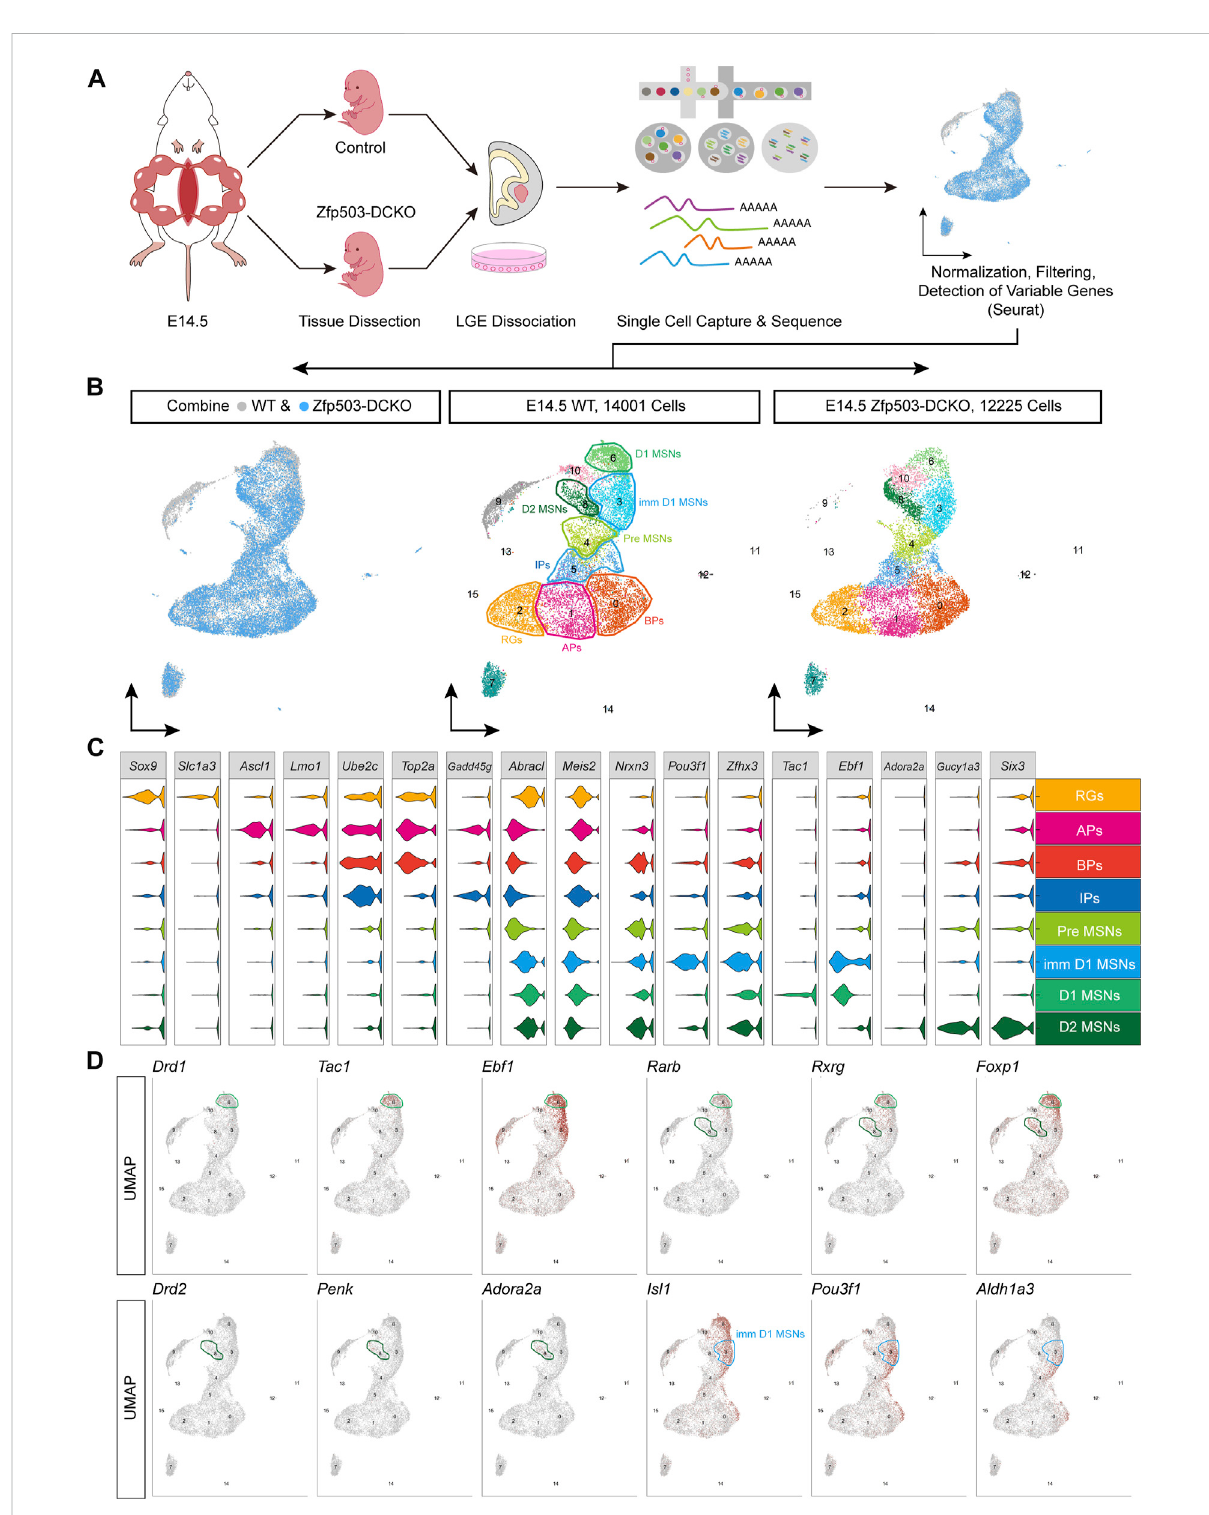
ThematurationofD1MSNsoccursearlierthanthatofD2MSNs. (A) Work fl owofscRNA-seqofLEGsamplesatE14.5.LGEtissuesweredissected from embryos and dissociated into single-cell suspensions. Single cells were captured into droplets with the 10x platform. After sequencing, cells were classi fi ed by their transcriptomes. (B) UMAP showing 16 clusters (C0 – C15); the major cell types are annotated in both the WT sample and the Dlx2-Cre; Zfp503 F/F ( Zfp503 -DCKO) sample. (C) Violin plot showing cluster annotations, cell type assignments (y-axis) and the expression of 17 marker genes (x-axis). (D) Feature plots of the 12 marker genes in 16 different cell types in the WT sample. Abbreviations: Radial glia cells (RGs); apical progenitors (APs); basal progenitors (BPs); intermediate progenitors (IPs); premature MSNs (Pre-MSNs); immature D1 MSNs (Imm-D1